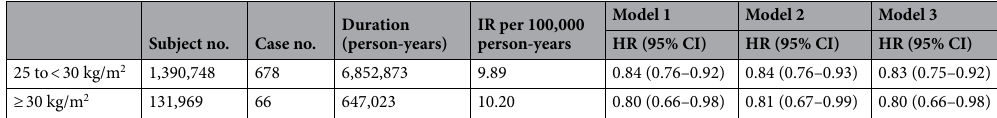
Table 2. Hazard ratios and 95% confidence intervals of demographic, comorbid, and behavioral factors for development of idiopathic macular hole. IR incidence rate, HR hazard ratio, CI confidence interval, Q quartile. Model 1: adjusted for age and sex. Model 2: adjusted for demographic factors (age, sex, income level) and systemic comorbidities (hypertension, dyslipidemia, stroke, heart disease, chronic kidney disease). Model 3: adjusted for demographic factors, systemic comorbidities, and behavioral factors (smoking history, drinking habit, physical activity, body mass